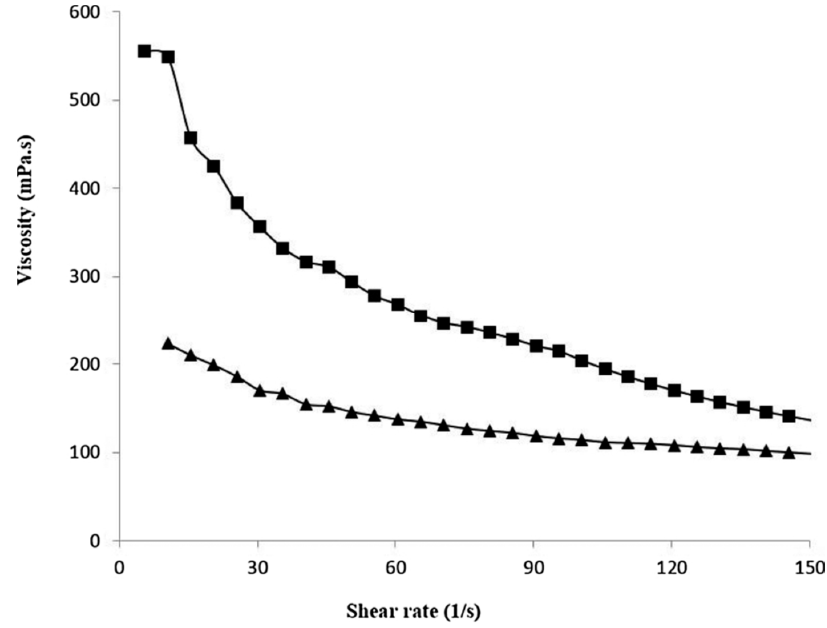
Figure 8. Viscosity-shear rate curves of dispersions (1%) of PM-pectin-CNTs ( ▲ ) and CIpectin-CNTs ( ■ ) at 25 ℃ as measured by rotational viscometry (Reproduced with permission [157]). The viscosity difference between PM-pectin-CNTs and CI pectin-CNTs was found to be greater